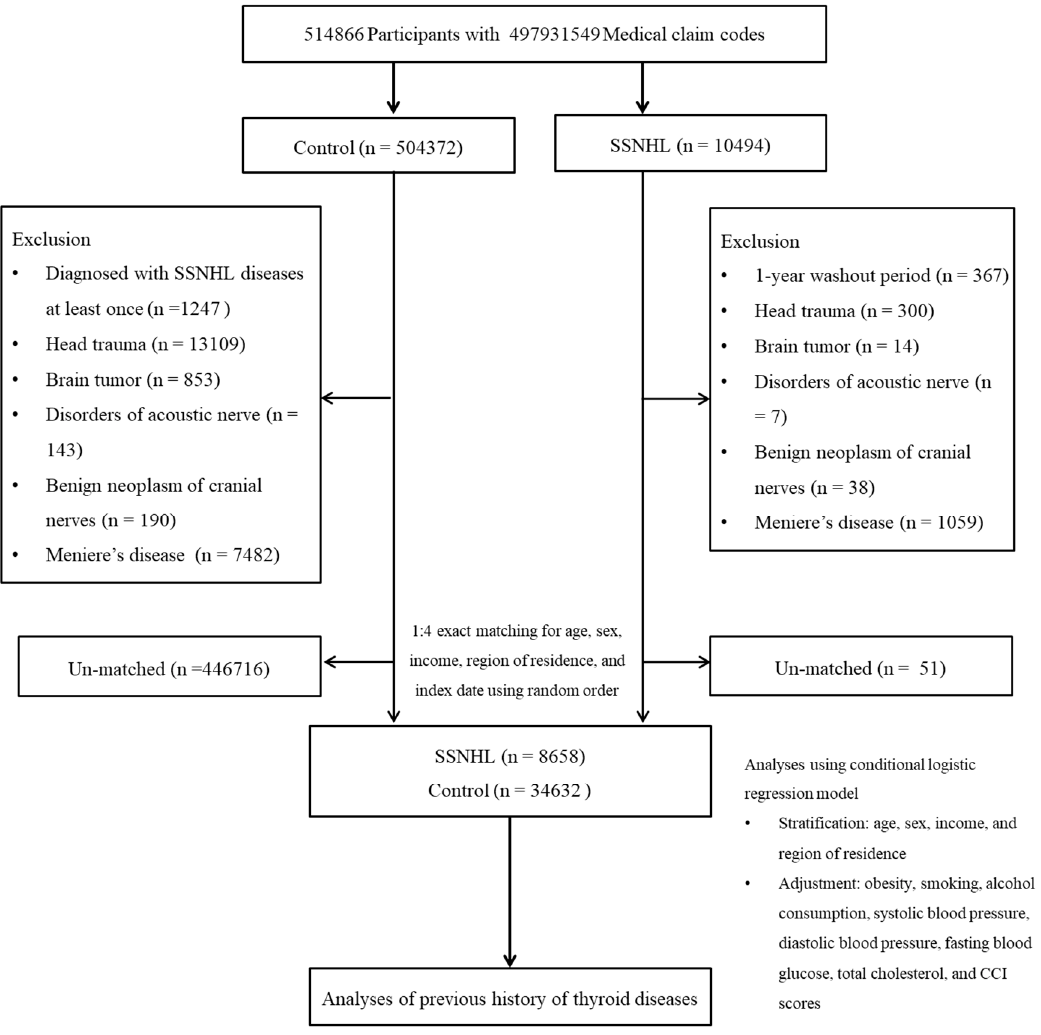
Figure 1. A schematic illustration of the participant selection process that was used in the present study. Of a total of 514,866 participants, 8658 of sudden sensorineural hearing loss (SSNHL) patients were 1:4 matched with 34,632 control participants for age, sex, income, and region of residence.